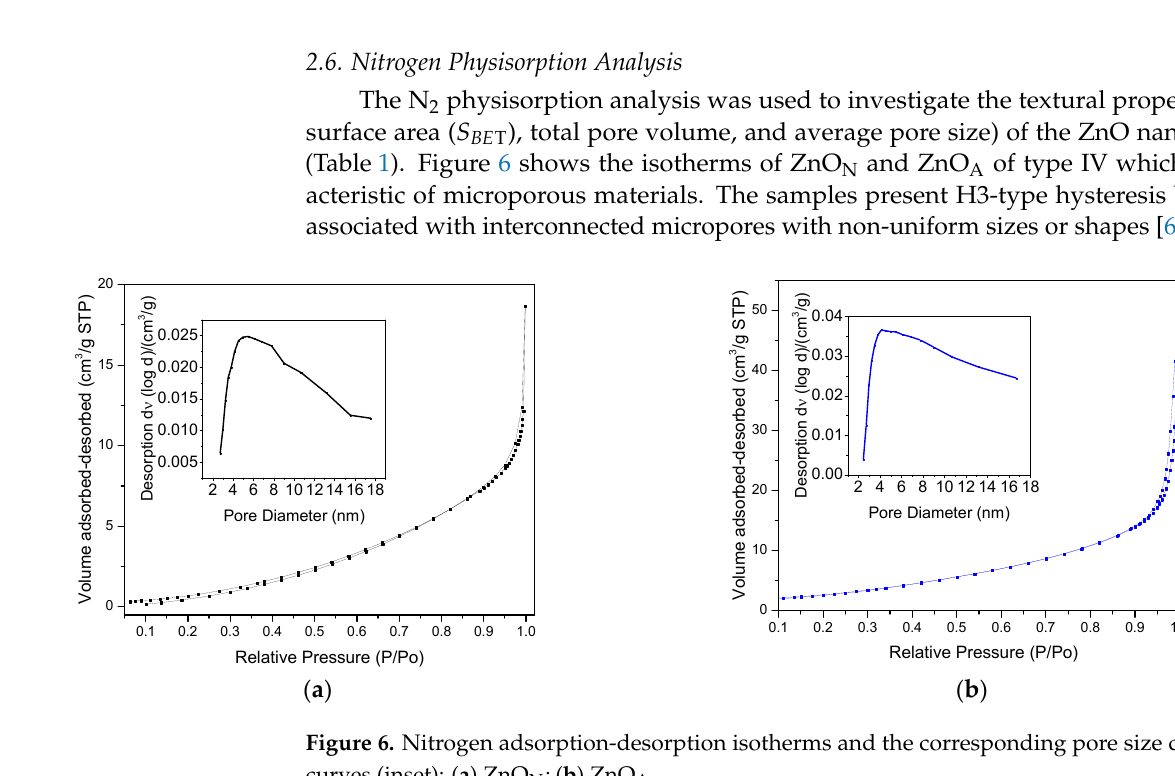
Figure 5. FT-IR spectra: ( a ) ZnO N ; ( b ) ZnO A .